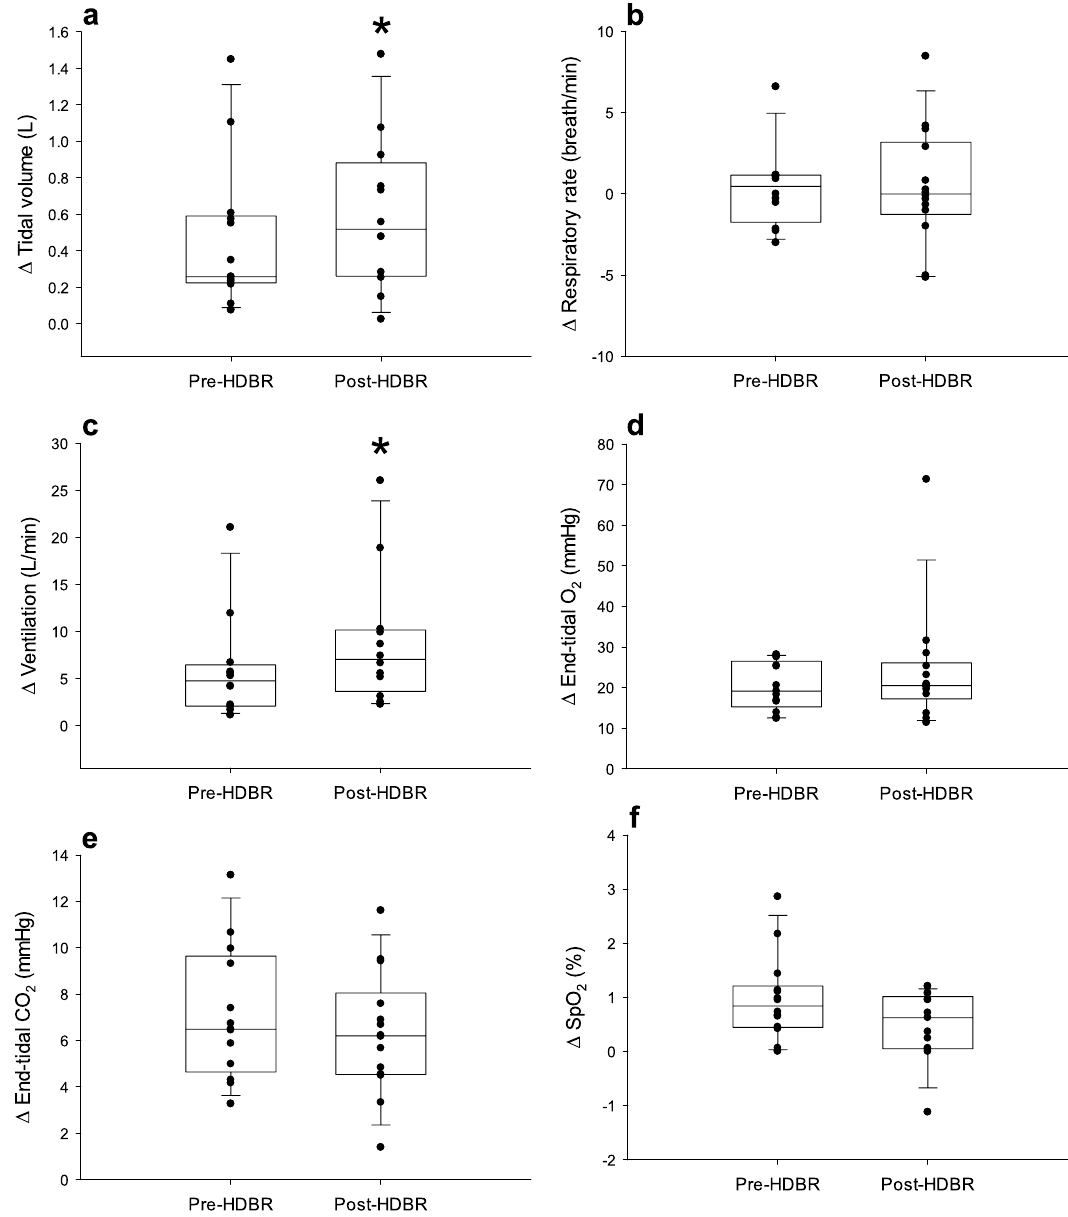
Figure 4. Change in tidal volume (a) , respiration rate (b) , ventilation (c) , end-tidal oxygen (d) , end-tidal carbon dioxide (e) , and oxygen saturation (f) from baseline to 5 min hypercapnia. *Significant main effect of HDBR. The line within each box indicates the median, whereas the lower and upper boundaries indicate the 25th and 75th percentiles. Lower and upper whiskers represent the 10th and 90th